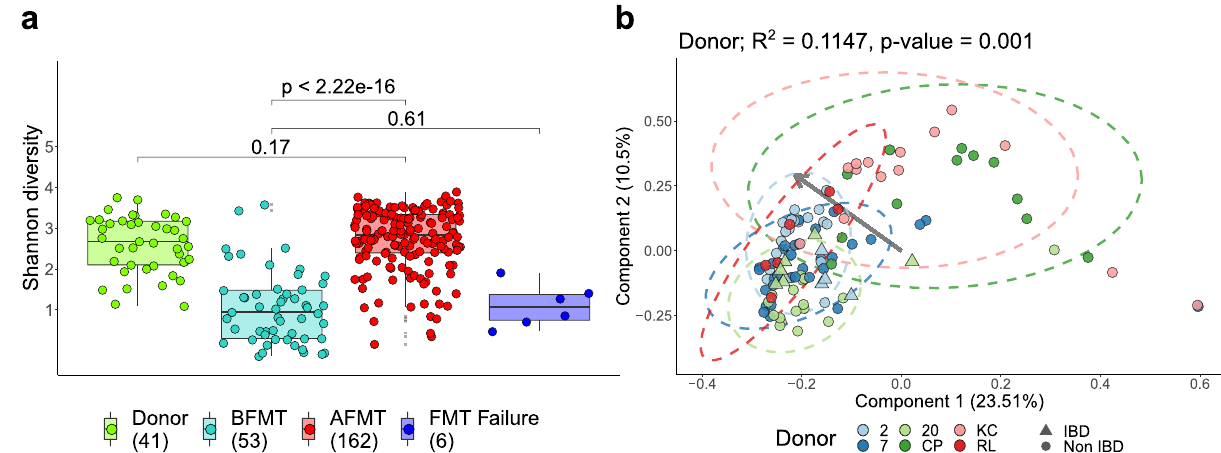
Figure 7. Restoration of the human plasmidome following faecal microbiota transplants (FMT). ( a ) The Shannon index α-diversity of FMT patient plasmidomes after FMT (AFMT) resembles that of donor plasmidomes. No significant difference (Wilcoxon test, p ≤ 0.05) is observed between plasmidome α-diversities before FMT (BFMT) or if the FMT was recorded as unsuccessful in treating Clostridioides difficile . ( b ) The β-diversity ordination of faecal plasmidomes after FMT, with the permutational multivariate analysis of variance (PERMANOVA) R 2 highlighting recipients closely resemble their donors up to 12 weeks AFMT. The origin- centred grey arrow indicates the directionality of increasing intra-sample